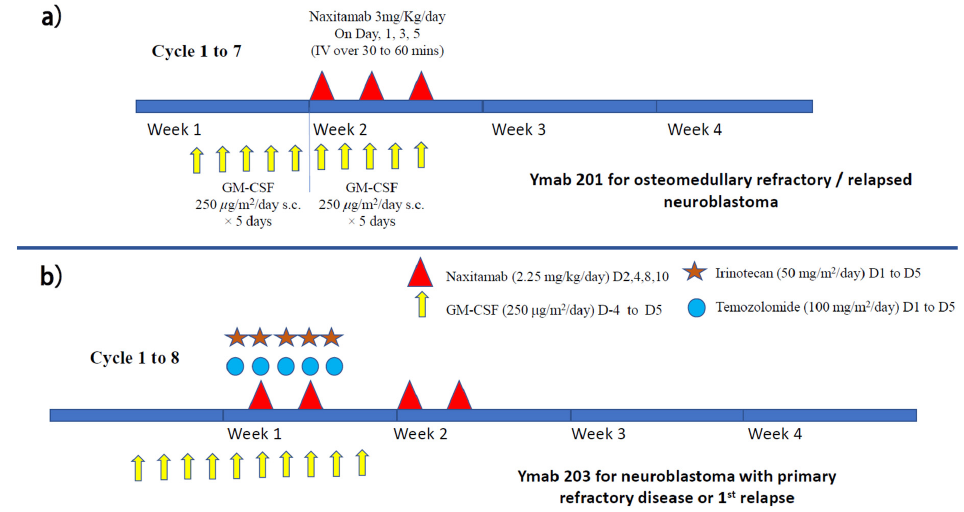
Figure 5. Treatment schema of ( a ) naxitamab maintenance immunotherapy with GM-CSF (for patients with CR1 (protocol 202) or osteomedullary refractory disease/relapse (protocol 201)) and ( b ) naxitamab immunotherapy with GM-CSF for neuroblastoma patients with fist relapse associated with soft tissue lesion (protocol